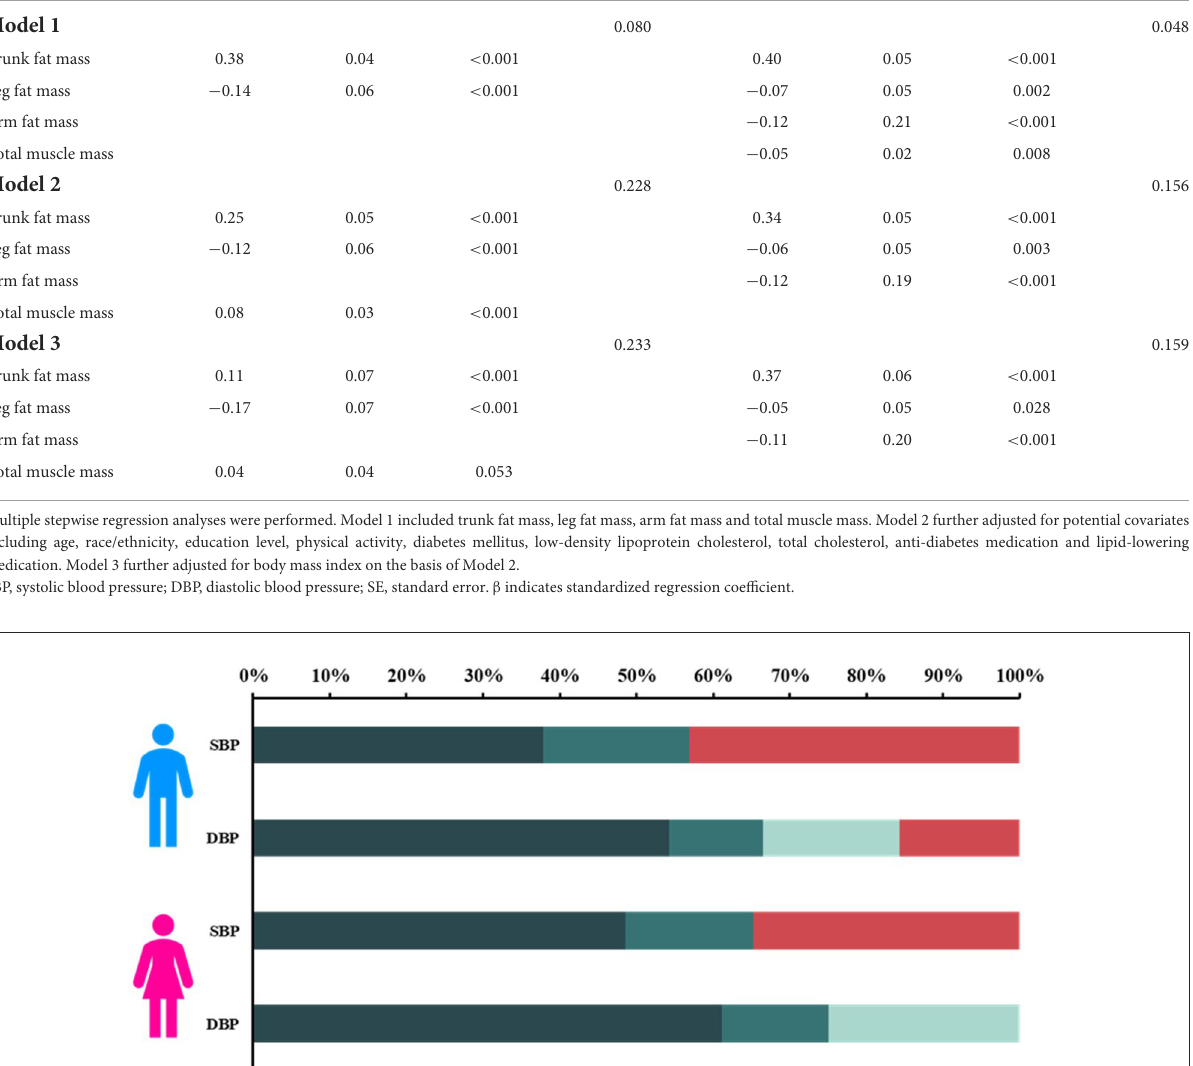
for women; P < 0.005 for both sexes; Arm: β = − 0.11